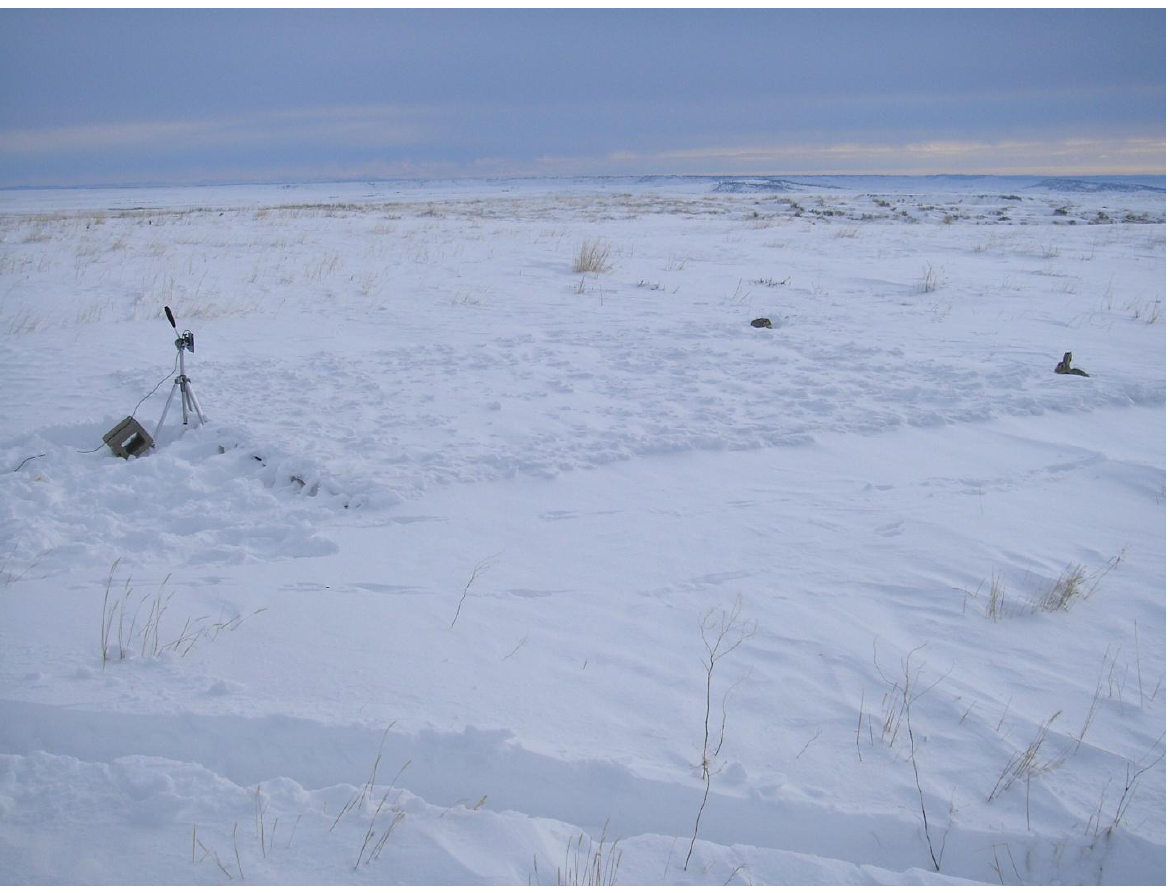
Figure 2. Snow-covered ground reflector. The antenna is mounted vertically on the tripod with h = 45.1